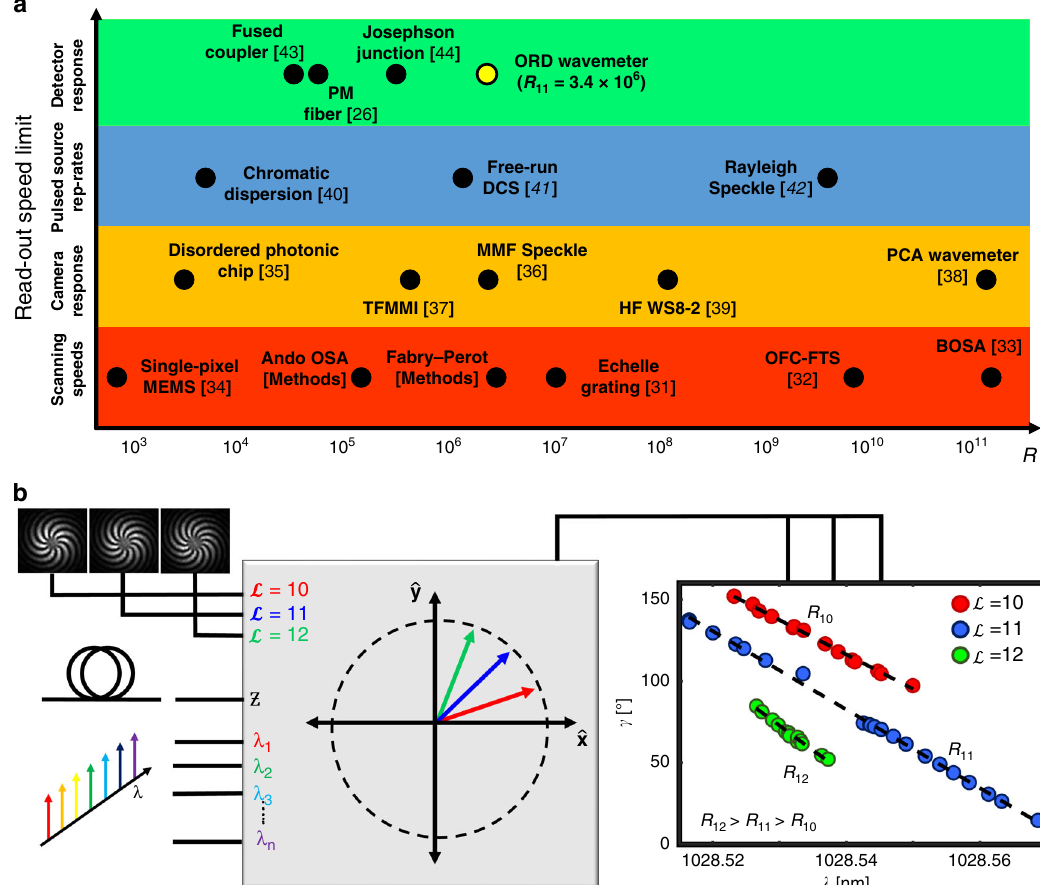
Fig. 4 Spectroscopic application space and multiplexing. a Performance metric chart of various spectroscopic devices – wavemeters, spectrometers, interferometers – using resolving power and categorized speed constraints. Red (bottom) band is for scanning devices, generally with mechanically moving parts. Orange is for devices that measure spatial intensity distributions with cameras. Devices whose speed depend on the pulse repetition rate of its laser source(s) are in the blue band. Lastly, green (top band) is for single-shot devices, which are principally speed constrained by the response time of their high-speed photodetectors. The ORD wavemeter (indicated in gold) demonstrates the highest resolving power of a device belonging in the green band. Abbreviations listed in Supplementary Note 7. b Multiplexing capabilities of the ORD wavemeter. Required inputs are OAM mode order L , vortex fi ber length, and a wavelength sweep. For OAM of different L there are different strengths of optical rotation with wavelength, hence distinct α and resolutions ( R 10 , R 11 , and R 12 ) can be identi fi ed. The multitude of available OAM modes in vortex fi bers could be employed to develop generalized, multiplexed spectral measurement devices across wider wavelength